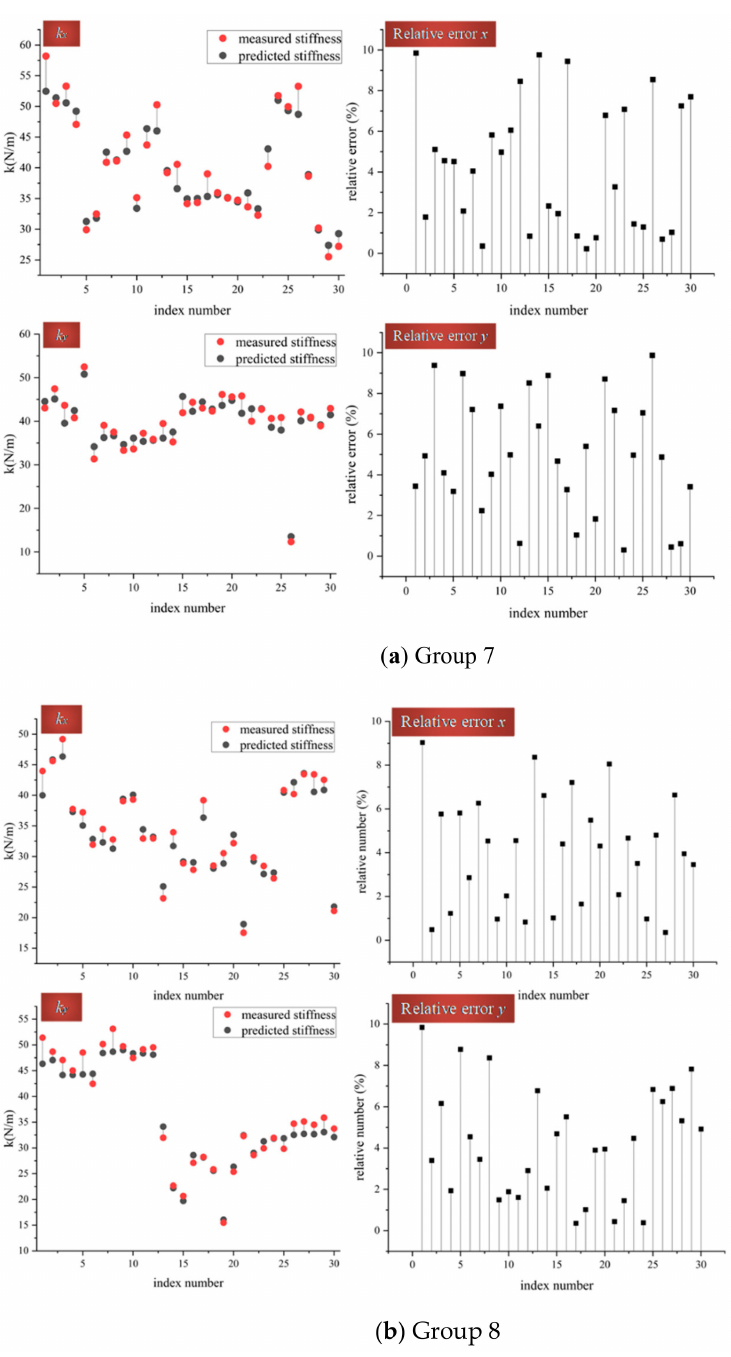
Figure 5. The comparison of tangential contact stiffness between measured ones and predicted ones among different